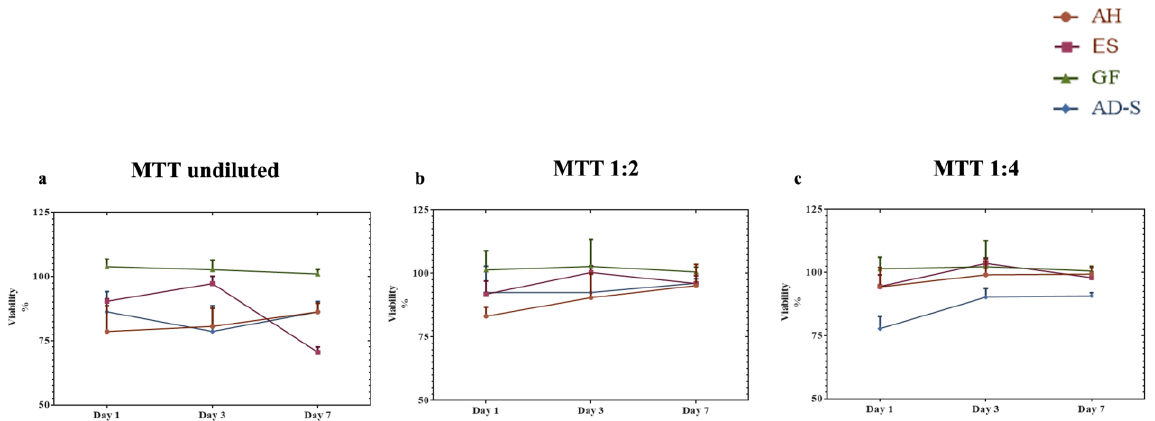
Figure 2. MTT assay showing the mean percentage of cell viability with standard deviation after exposure to the different sealers in medium. Data obtained by each group was normalized based on cells + medium (control). ( a ) Undiluted eluates. ( b ) Dilution 1:2. ( c ) Dilution 1:4.